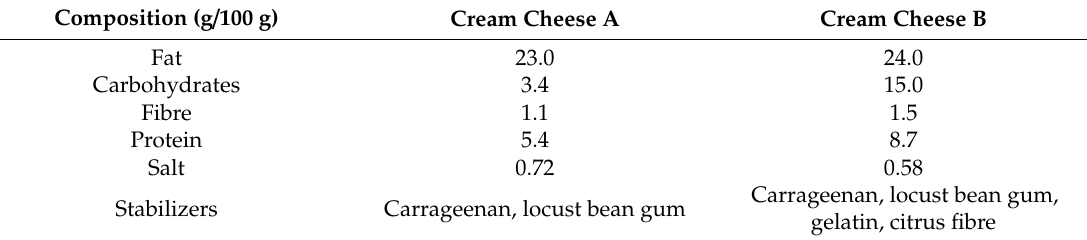
Table 1. Compositional information of full fat cream cheese